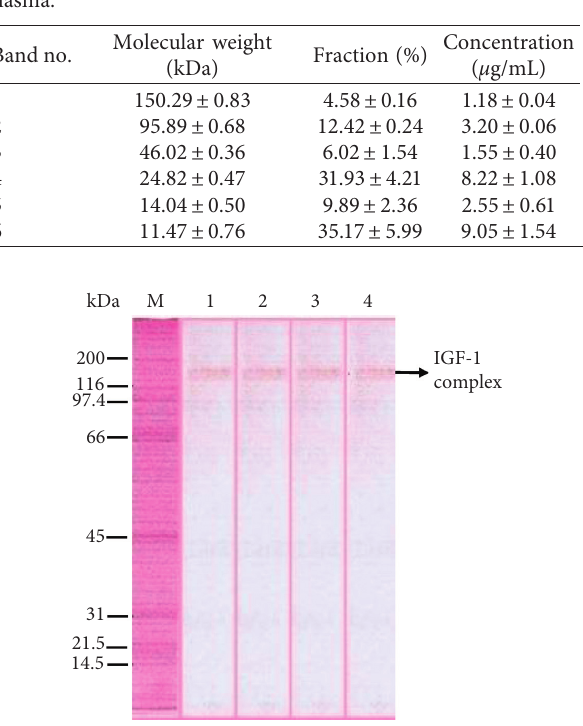
Figure 2: Western blot of IGF-1 complex protein derived from Simmental bull seminal plasma protein. kDa: kilo Dalton, M: marker, 1 and 2: seminal plasma of first Simmental bulls, and 3 and 4: seminal plasma of second Simmental bulls.